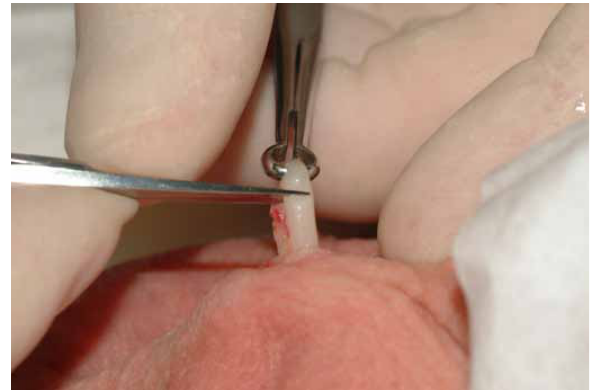
Figure 2 - Hemi-transecting the vas with scissors.